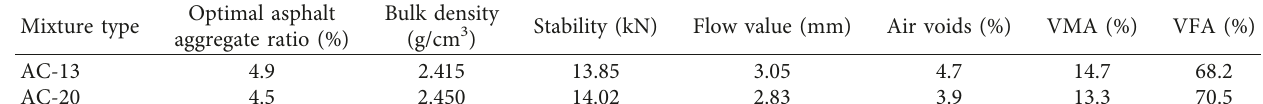
Table 1: Summary of volumetric parameters of asphalt mixture.